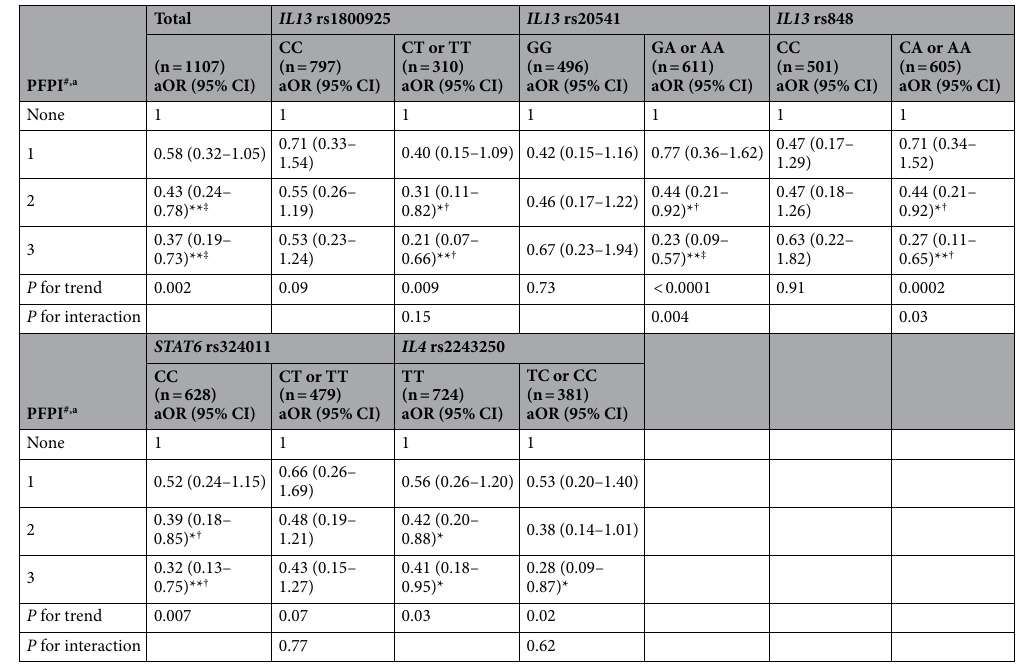
Table 5. Dose–response associations of prenatal food protective index with cord blood total IgE elevation modified by genetic polymorphisms. PFPI, prenatal food protective index; aOR, adjusted odds ratio; 95% CI, 95% confidence interval. # PFPI includes any fairly lean fish, daily fruit, and absence of any canned fish. a Adjusted for neonatal sex, gestational age, birth body weight, maternal age, parental education, family history of atopic diseases, environmental tobacco smoke, and perception of mildewy odour. * P < 0.05, ** P < 0.01, † P < .05 after FDR correction, ‡ P < .01 after FDR